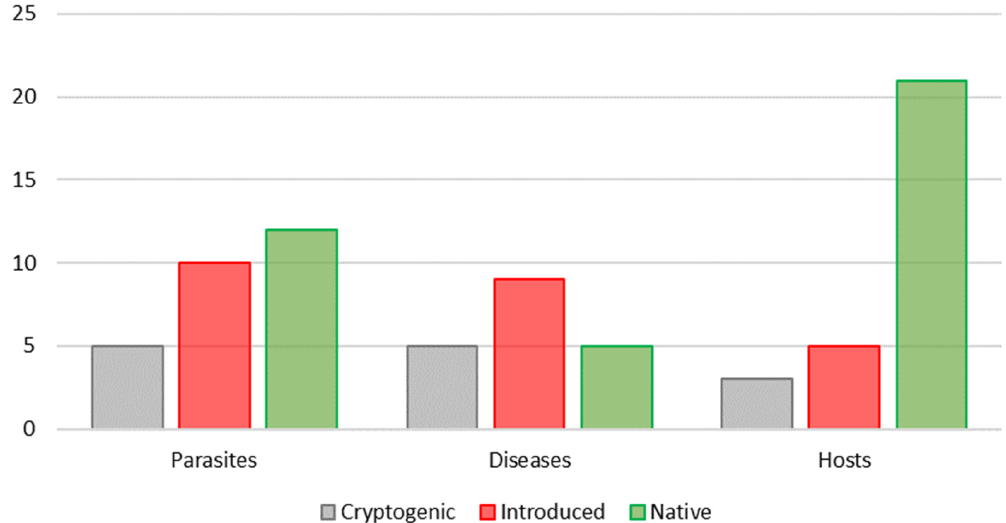
Figure 10. Diversity of parasites, transmitted diseases and hosts depending on the status of the hosts: cryptogenic (grey), introduced (red) and native (green).